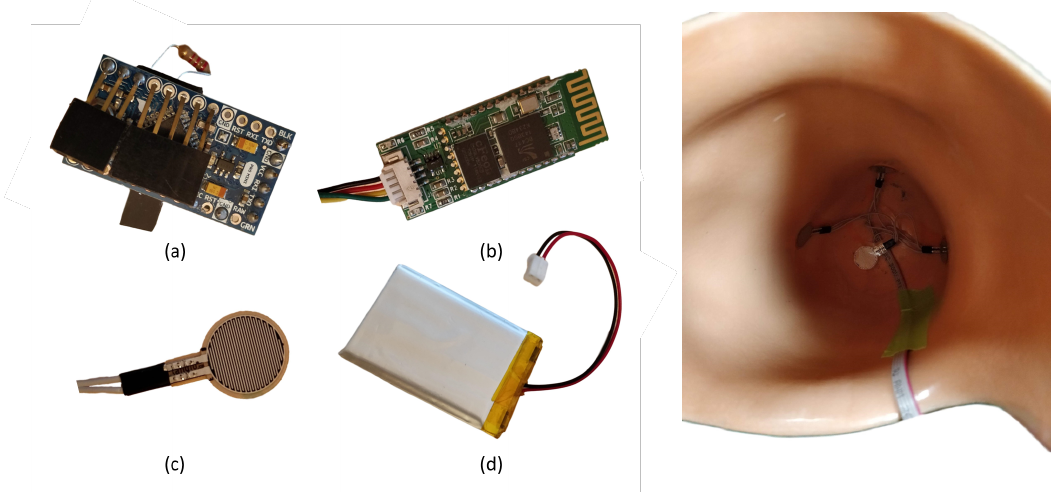
Figure 1. The hardware setup. The figure on the left shows the main components of the system: ( a ) an Arduino Pro Mini board, ( b ) a Bluetooth module, ( c ) a force sensitive resistor, ( d ) a lithium polymer battery. The figure on the right shows the placement of the four force sensitive resistors (FSRs) inside the socket in the distal, anterior distal, lateral distal, and medial distal locations. The image shows the lower limb prosthetic socket from the top. The bottom of the image shows the posterior side of the